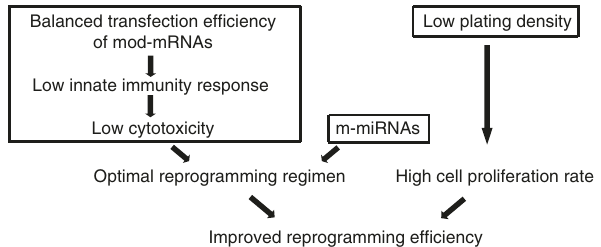
Fig. 8 The mechanism underlying the enhanced reprogramming activity of the optimized RNA-based approach. The schematic depicts the proposed mechanism by which the optimized RNA-based reprogramming